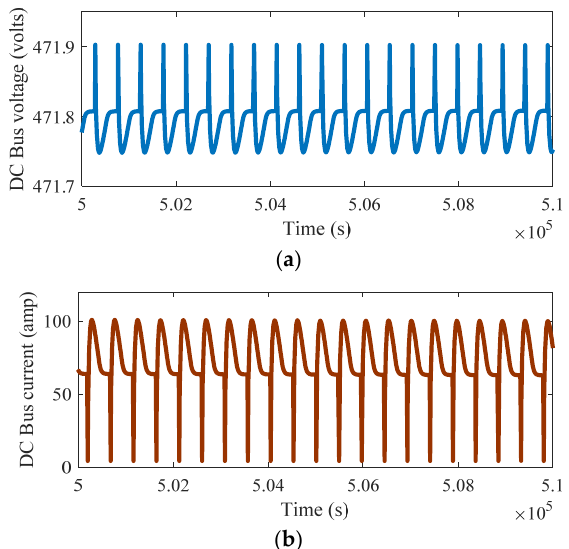
Figure 12. DC Bus values ( a ) Voltage vs Time and ( b ) Current Vs Time.